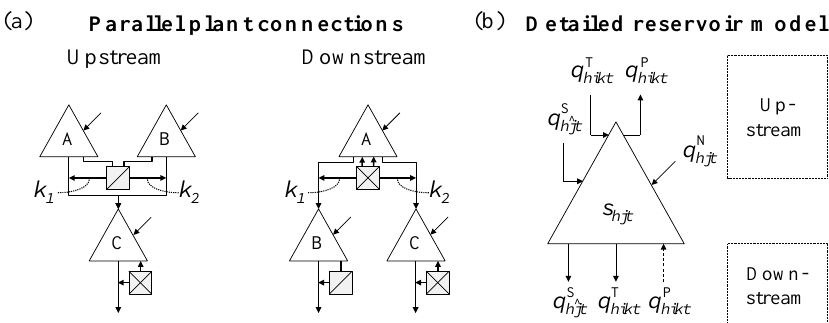
Figure 4. ( a ) Schematic illustration of parallel up- and downstream hydro plant connections; and ( b ) overview of the detailed hydro reservoir